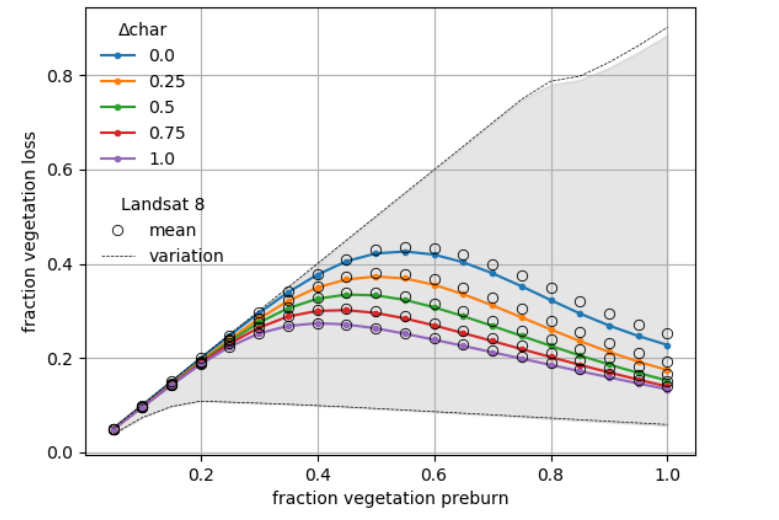
Figure A16. Vegetation loss results depending on starting vegetation fraction and ∆ char param- eter setting, park-wide for the Moderate Resolution Imaging Spectroradiometer (MODIS), dNBR threshold = 0.15. Mean values are shown in colored lines, with total model result variation shown in gray. To compare, the results for Landsat 8 are shown in black, with mean values shown by circles and total model result variation shown by dashed